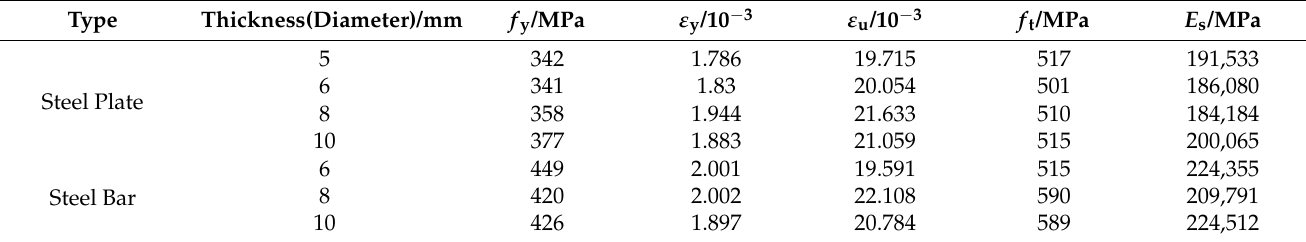
Table 3. Mechanical properties of